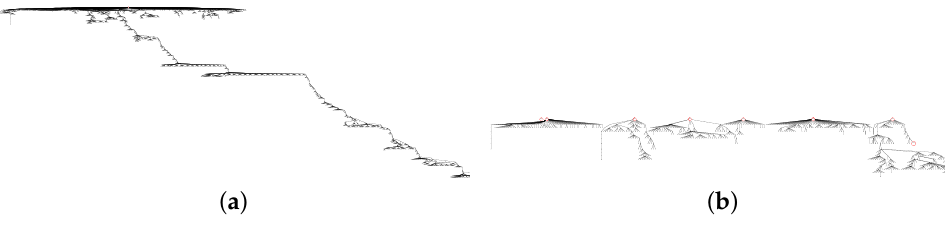
Figure 2. The search paths of CAR and r-CAR (CAR + restart policy) algorithms on solving the instance “oski15a08b09s”. Zooming in on the pictures will not cause distortion. ( a ) The search path of CAR algorithm. ( b ) The search path of r-CAR